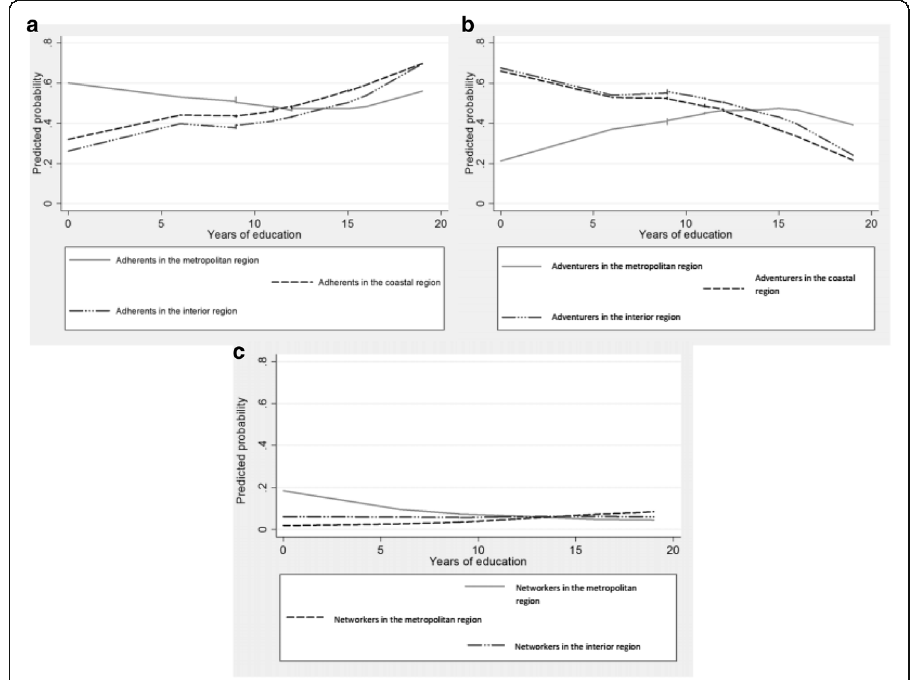
Fig. 5 a – c Predicted probabilities of three types of successful job seekers by education and region — X-axis measures education by years, and Y-axis measures probabilities (between 0 and 1); the long-dash-dot-dot-dot line indicates the interior region, the short-dash line indicates the coastal region, and the solid line indicates the metropolitan region. a The predicted probability of being adherents in three regions. b The predicted probability of being adventurers in three regions. c The predicted probability of being networkers in three